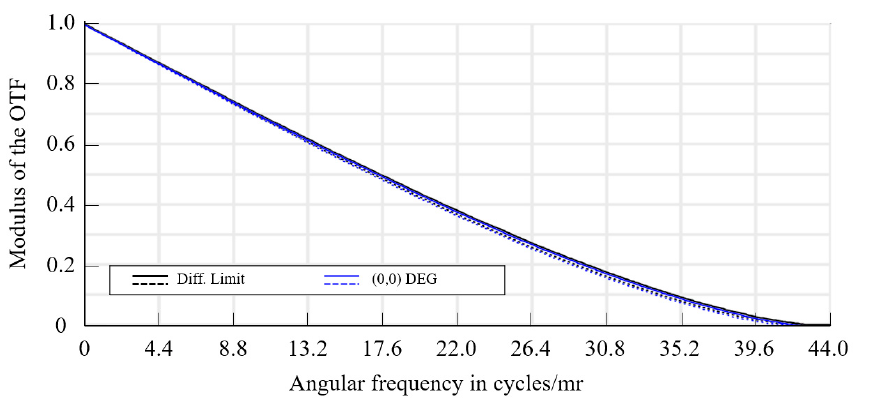
Figure 12. Initial structure modulation transfer function (MTF) of the off-axis four-mirror system.